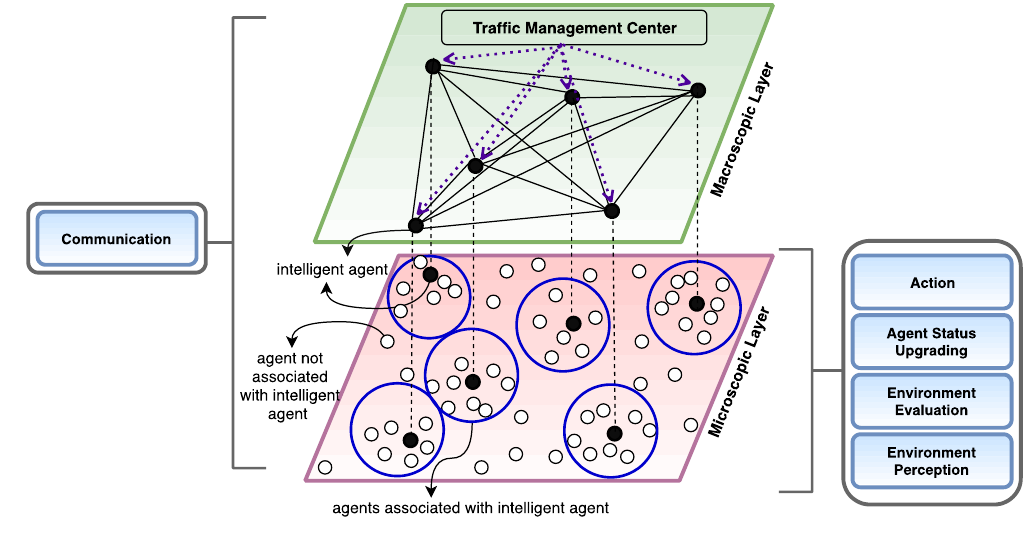
Figure 2. MLMS-ABM Figure 2. MLMS-ABM layers.